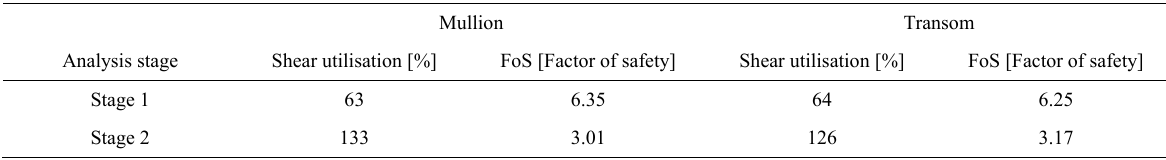
Table 3: Permanent stresses on structural sealant.